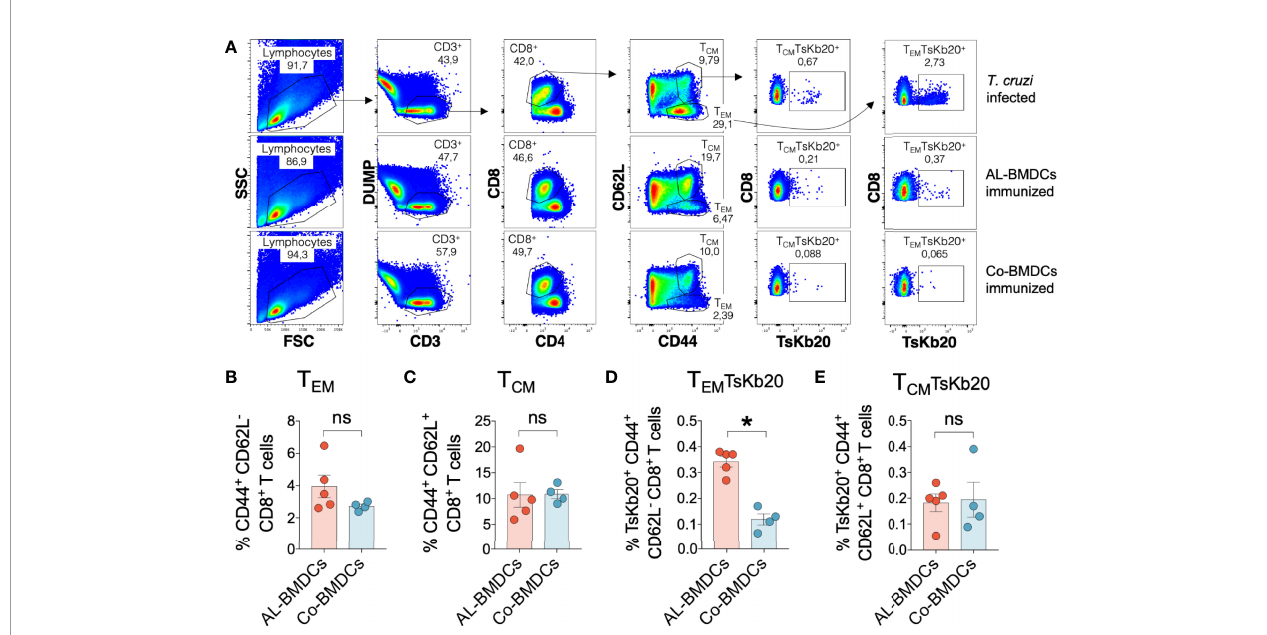
FIGURE 3 | Memory CD8 + T cell response in mice immunized with AL-BMDCs or Co-BMDCs. (A) Gating strategy used to analyze central memory CD8 + T cells (T CM , CD62L + and CD44 + ), effector memory CD8 + T cells (T EM , CD62L - and CD44 + ), TsKb20-speci fi c central memory CD8 + T cells (T CM TsKb20) and TsKb20- speci fi c effector memory CD8 + T cells (T EM TsKb20) in lymph nodes from mice infected with T. cruzi (top), immunized with AL-BMDCs (middle), or immunized with Co-BMDCs (bottom). Singlets were previously selected (not shown). Comparison of the percentages of (B) T EM ; (C) T CM ; (D) T EM TsKb20 and (E) T CM TsKb20 between mice immunized with AL-BMDCs and Co-BMDCs. Mean + SEM is plotted in all bar graphs [n = 6 per group, Mann-Whitney test, p-values = 0.1905 (B) ,